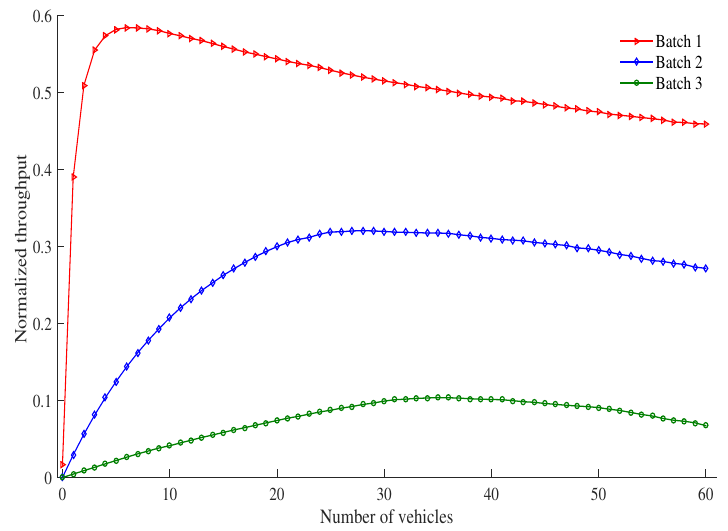
Figure 11. Normalized throughput vs. number of